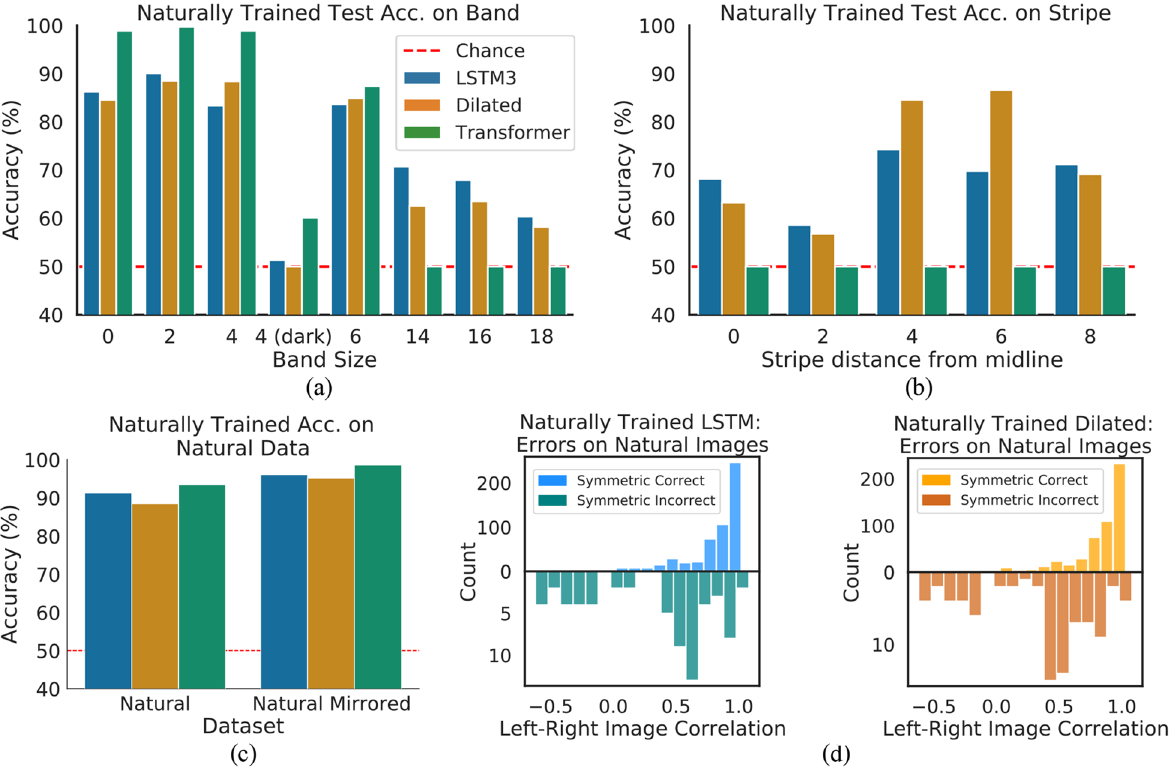
Figure 8. Generalization performance of naturally trained LSTM3 , Dilated , Transformer . ( a ) Accuracies on the Band datasets. ( b ) Accuracies on the Stripe datasets. ( c ) Accuracies on natural image datasets. ( d ) An analysis of symmetric images correctly/incorrectly classified by LSTM3 and Dilated . The histograms show the number of images correctly or incorrectly classifoed depending on the degree of non-symmetry, which is evaluated as the correlation between the left and right (flipped) halves of the images, where a higher correlation indicates that an image is more